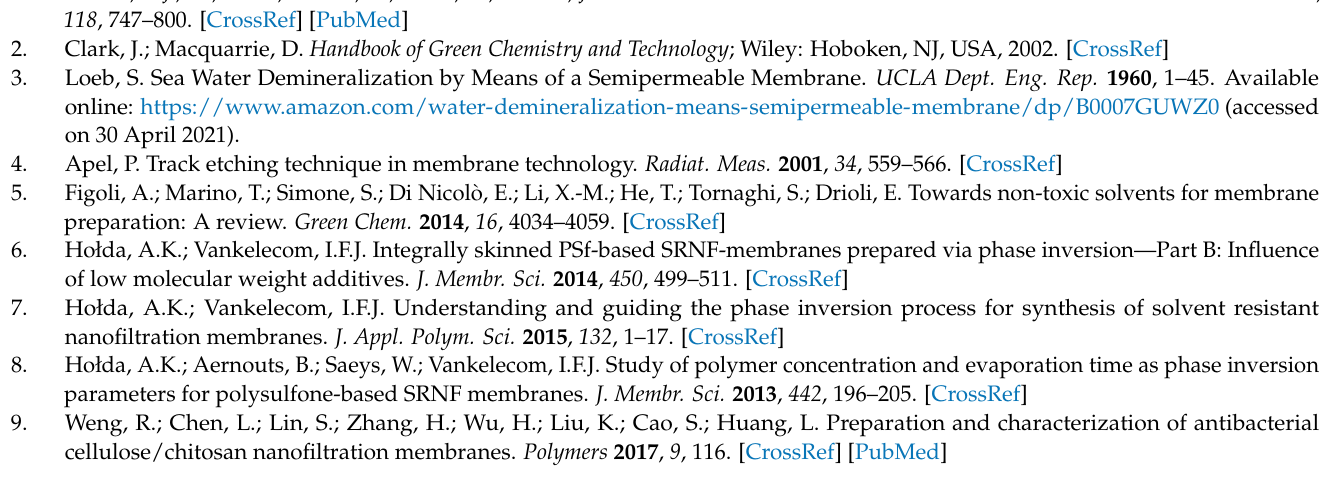
(RED) for CA. Table S2: Hansen solubility parameters and relative energy difference (RED) for PI. Table S3: Hansen solubility parameters and relative energy difference (RED) for PSU. Table S4: Hansen solubility parameters for PES and relative energy difference (RED) for PES. Table S5: Hildebrand/Hansen solubility parameters of GVL and interaction distance for CTA. Table S6: Solubility parameters difference (Ra) of GVL and non-solvent. Table S7: Comparison of the overall membranes performance of current membranes and a selection of lab-made and commercial membranes. Table S8: Comparison of the overall membranes performance of current membranes and a selection of lab-made and commercial membranes using MgSO 4 feed solution. References for supporting information are cited in the supplementary materials separately